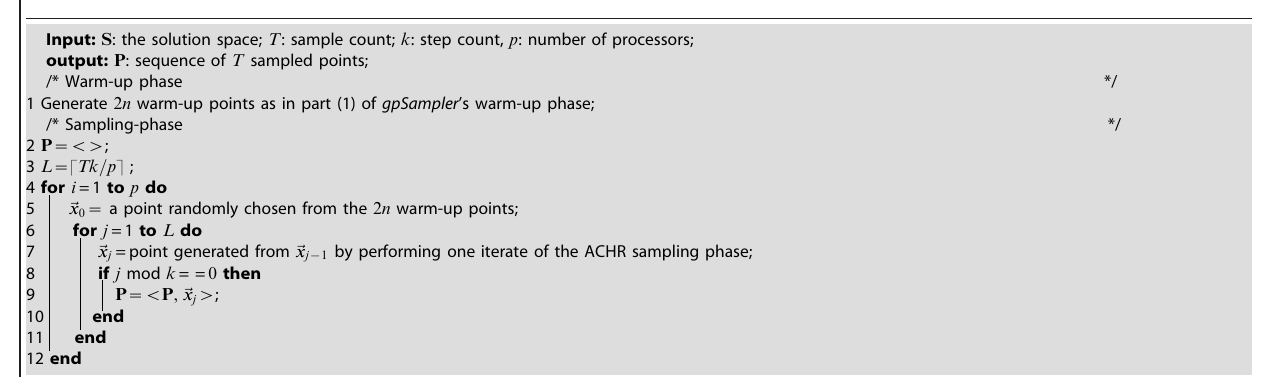
Table 1. Algorithm 1.